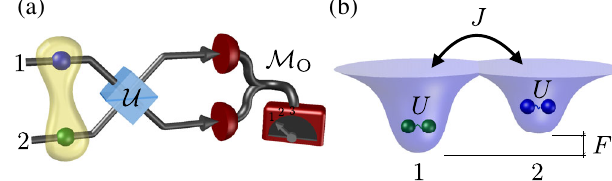
FIG. 6. Experimental settings to illustrate the complementarity relations (67) and (68), for systems of partially distinguishable, possibly interacting particles. (a) Hong-Ou-Mandel experiment: N ¼ 2 noninteracting partially distinguishable particles (colored balls), which can be correlated in their internal degrees of freedom (yellow envelope), evolve according to U ¼ u ⊗ N , with u the single-particle unitary matrix of the balanced beam ⃗ S splitter. The output mode occupation is measured according to the measurement M O (see main text) with an interference contrast controlled by Eq. (67). (b) Double-well Bose-Hubbard model: Each site (or mode) initially contains two particles, with particles on distinct sites prepared in distinct internal states with mutual overlap γ (see main text). The difference in the potential wells ’ on-site energies is controlled by the tilt F . Particles can tunnel with rate J and interact with strength U . After an evolution for some time t , different observables exhibit an interference contrast, which is bounded by the complementarity relation (67); see Fig. R ¼ 2 , ⃗ E ¼ ð 1 ; 2 Þ , and Σ ¼ S ϵ ; ð 12 Þg , with ϵ the 2 ¼ f identity permutation and Eq. (12) permuting the particles.